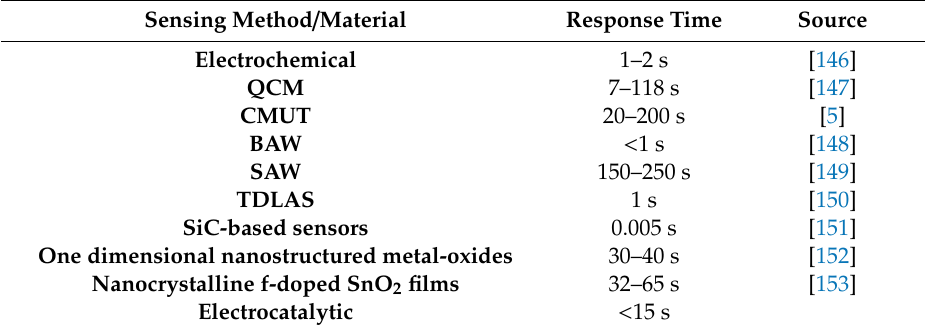
Table 4. Gravimetric detection methods and their response time